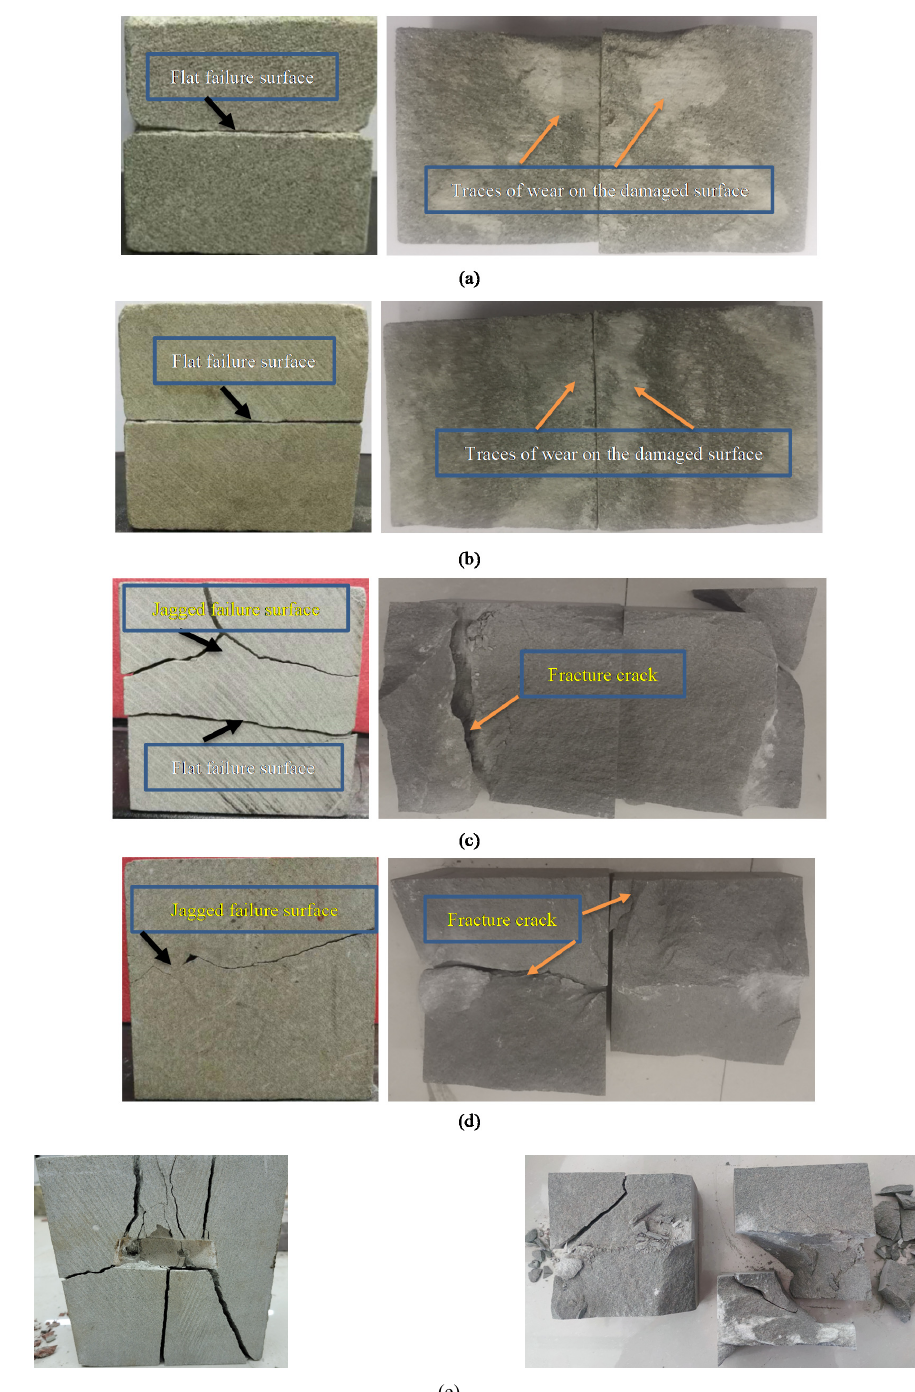
Figure 8. Straight shear experiment results of samples of different sizes. ( a ) Sample a1-1; ( b ) sample a2-1; ( c ) sample a3-1; ( d ) sample a4-1; ( e ) sample a4-2.